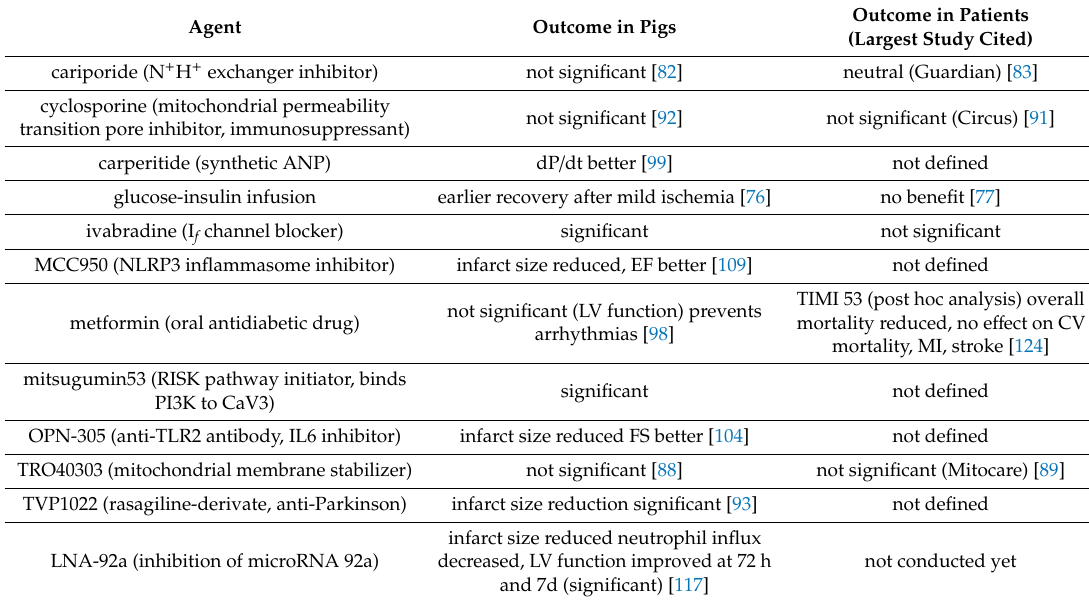
Table 1. Pharmacological agents assessed in porcine / human studies of ischemia-reperfusion. Agent Outcome in Pigs